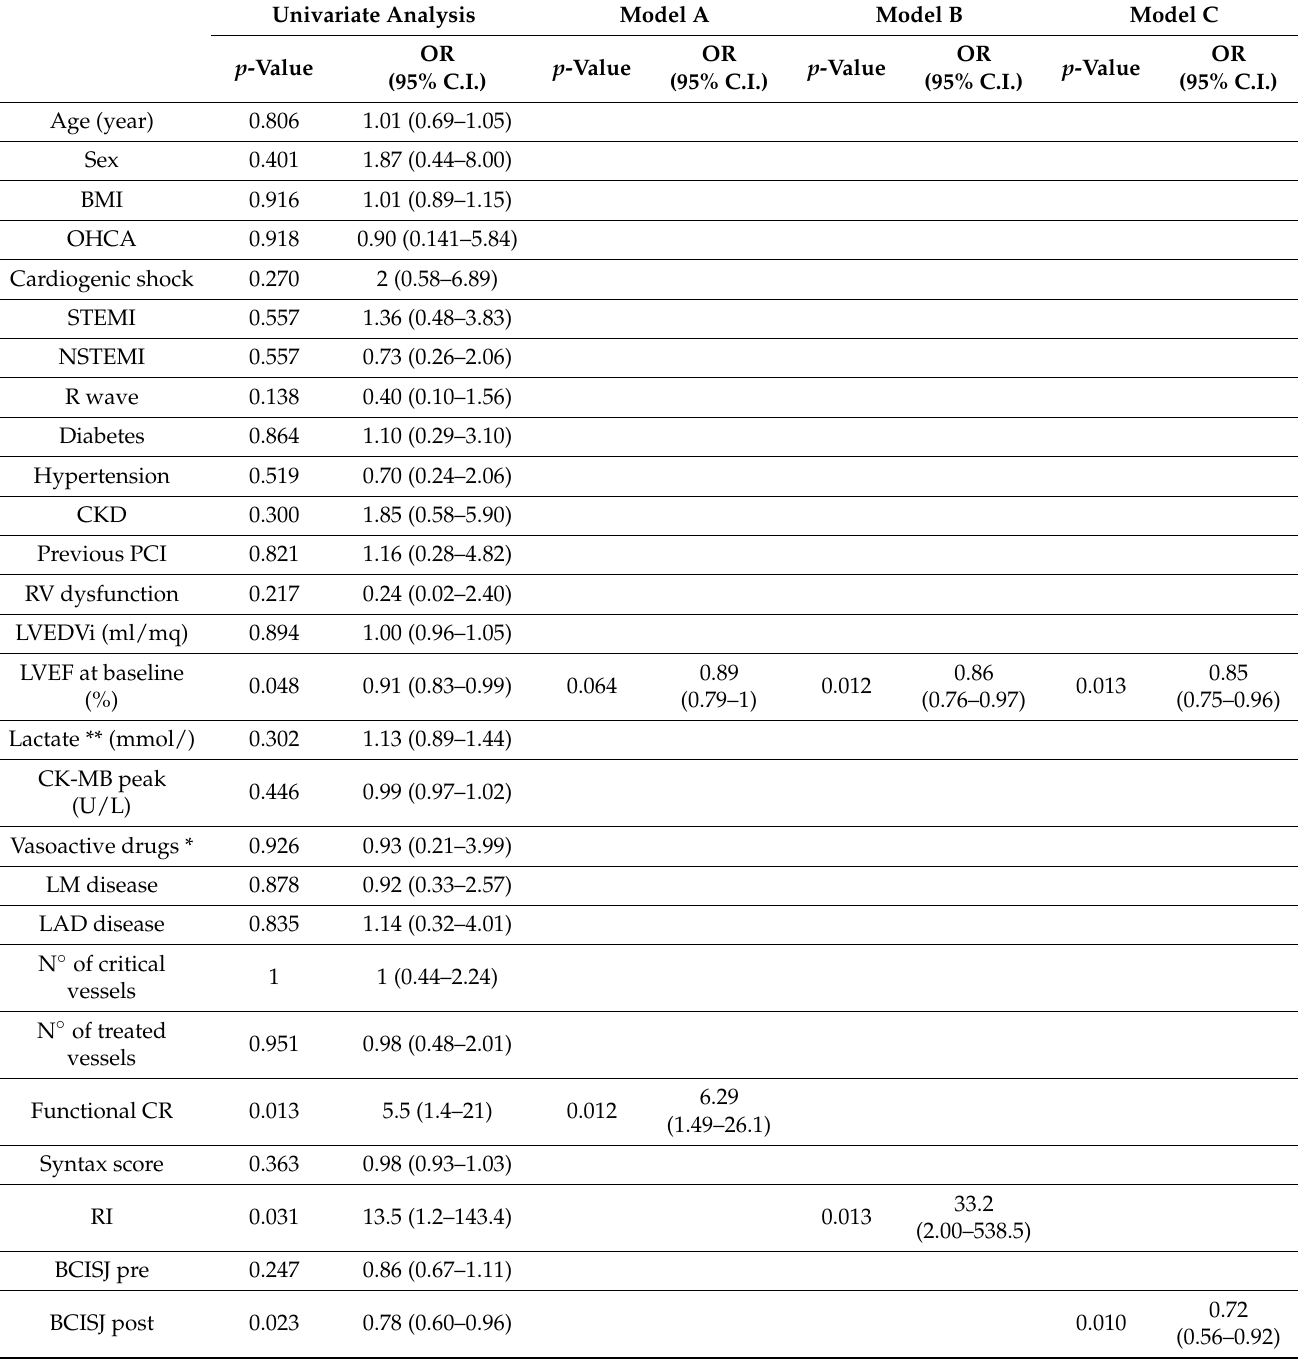
Table 4. Univariate and multivariate analysis of the predictors of LVEF recovery at follow-up. Univariate Analysis Model A Model B Model